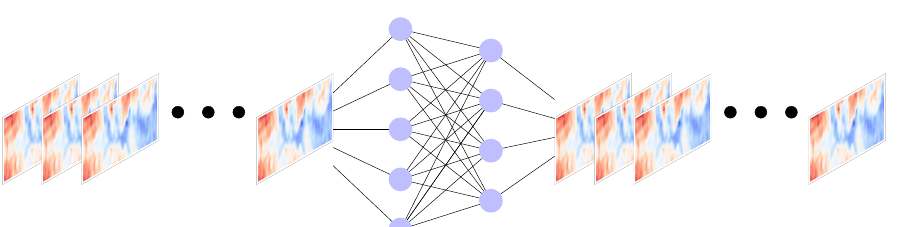
Figure 3. Single-scale SST prediction that uses the historical SST of single scale to predict the future single-scale SST.